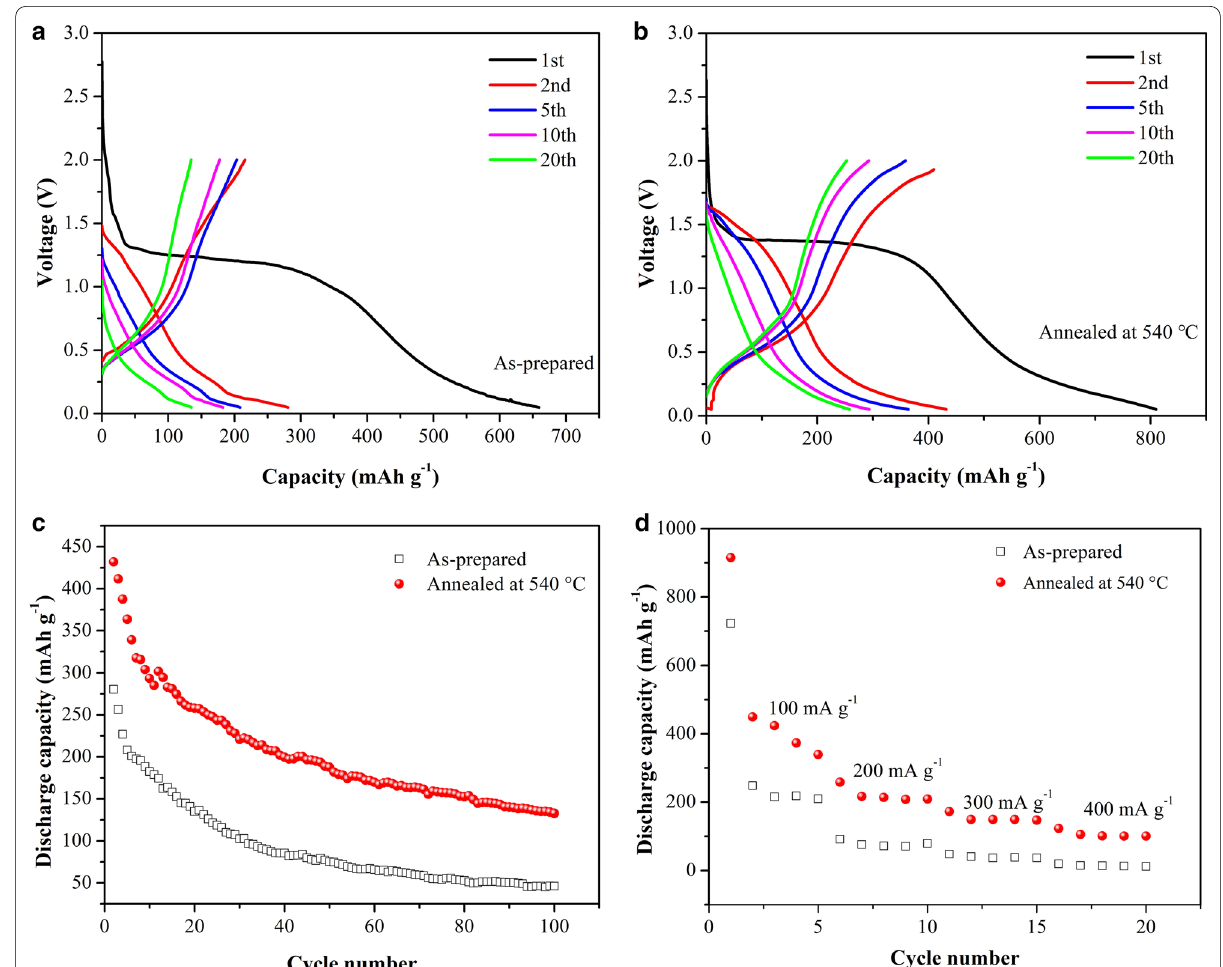
Fig. 9 Charge–discharge curves of Cu 2 SnS 3 electrodes (100 mA g − 1 ): a as-prepared and b annealed at 540 °C and c cycling performance (100 mA g − 1 ); d rate capability of as-prepared and annealed Cu 2 SnS 3 electrodes at varying current densities (100 to 400 mA g − 1